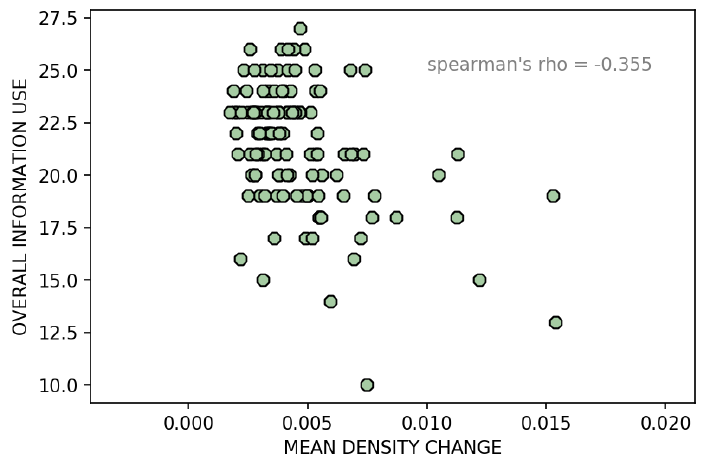
Figure 4. Feature Importance Scores for Both Tasks.